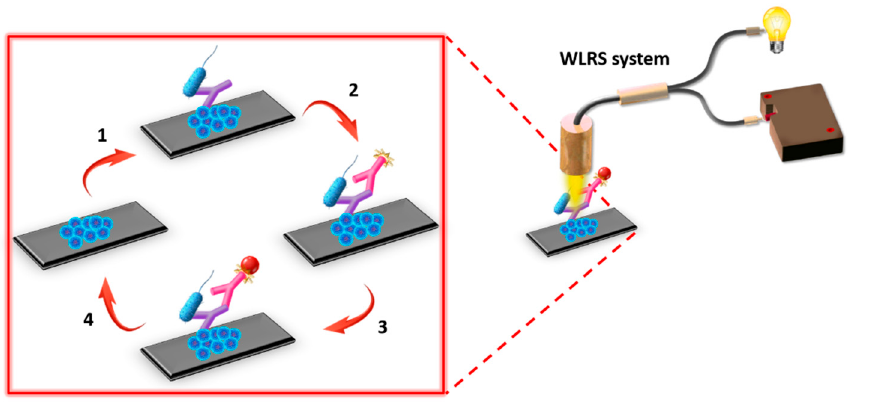
Figure 2. Assay configuration for the detection of S. typhimurium employing the WLRS system. The main assay steps included: (1) incubation of immobilized onto the chip lipopolysaccharide (LPS) with a mixture of bacteria calibrator and rabbit polyclonal anti- Salmonella antibody, (2) reaction with biotinylated Goat Anti-Rabbit IgG antibody (secondary antibody), (3) reaction with streptavidin, and (4) chip surface regeneration, i.e., removal of the immunosorbed molecules to use the chip for a new assay cycle.